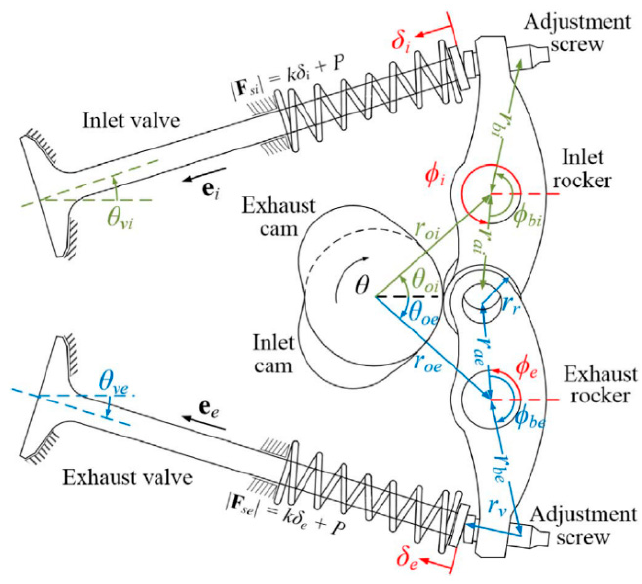
Figure 15. Schematic of the balancing mechanism [34]. Figure is reprinted with permission from publisher.